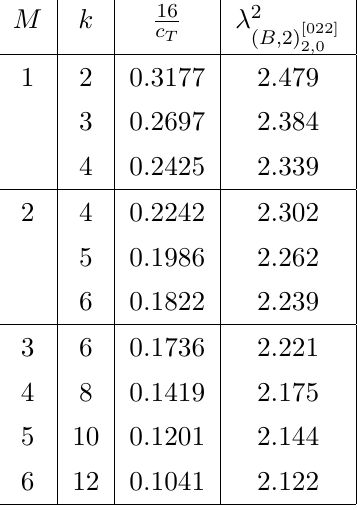
Table 8 . OPE coefficients 16